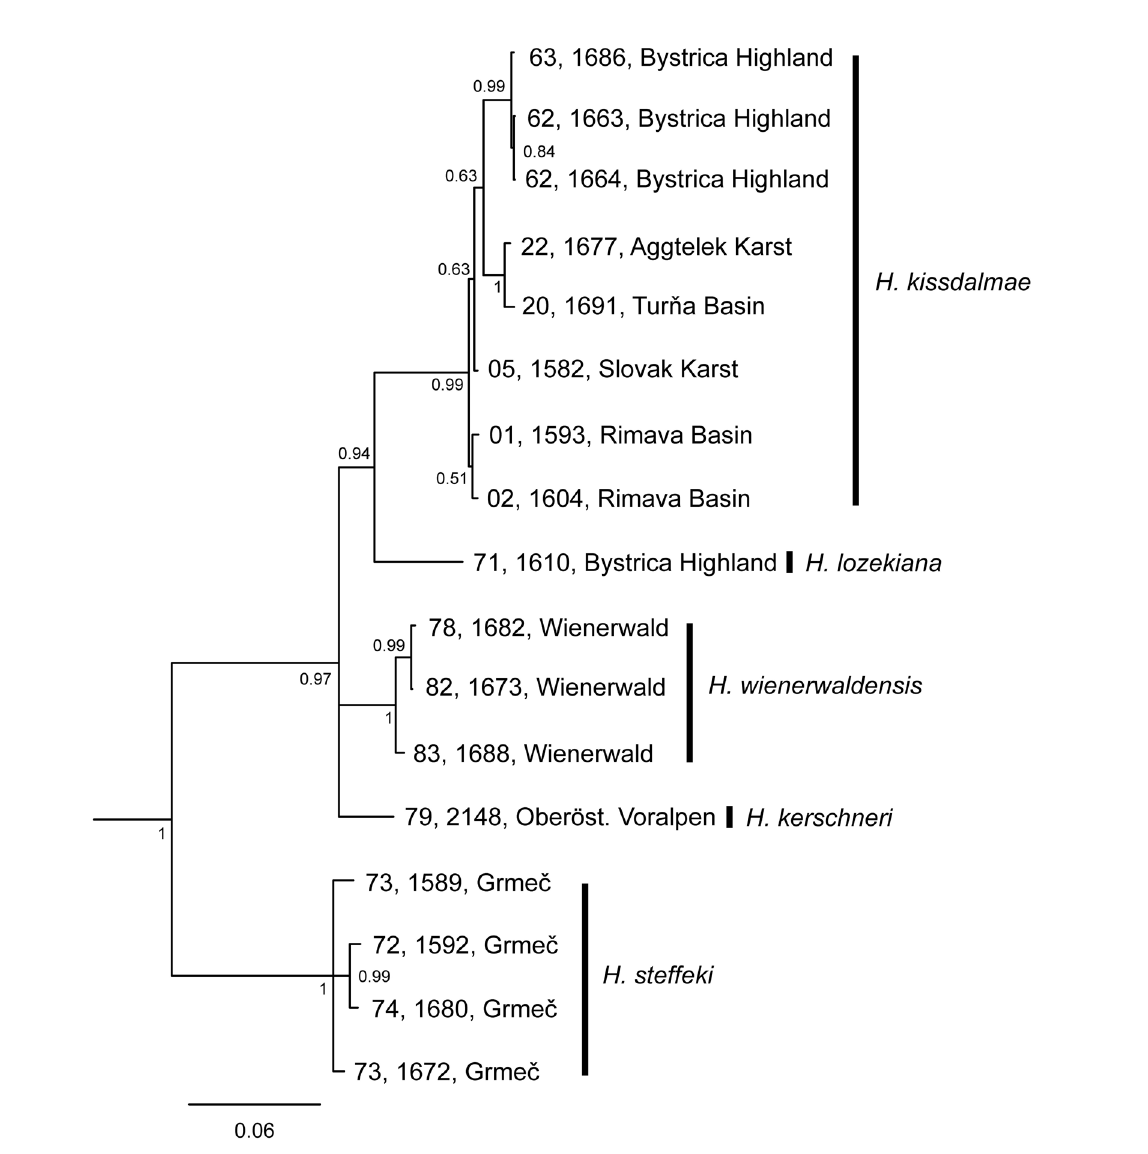
Fig. 8. Phylogenetic tree from Bayesian analysis in MrBayes based on COI, 16S rRNA and ITS2 (outgroup pruned off). Specimens identified by two-digit locality code in bold, four digit individual DNA code, and orographic unit (see Table 1); posterior probabilities at nodes; scale bar in substitutions per